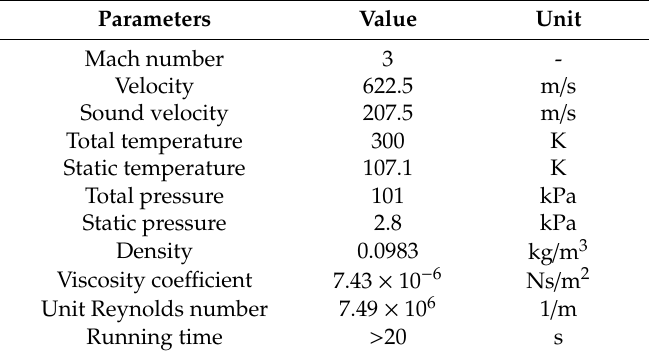
Figure 1. Schematic diagram of KD-2 supersonic wind tunnel. Table 1. Flow parameters in the experimental section.